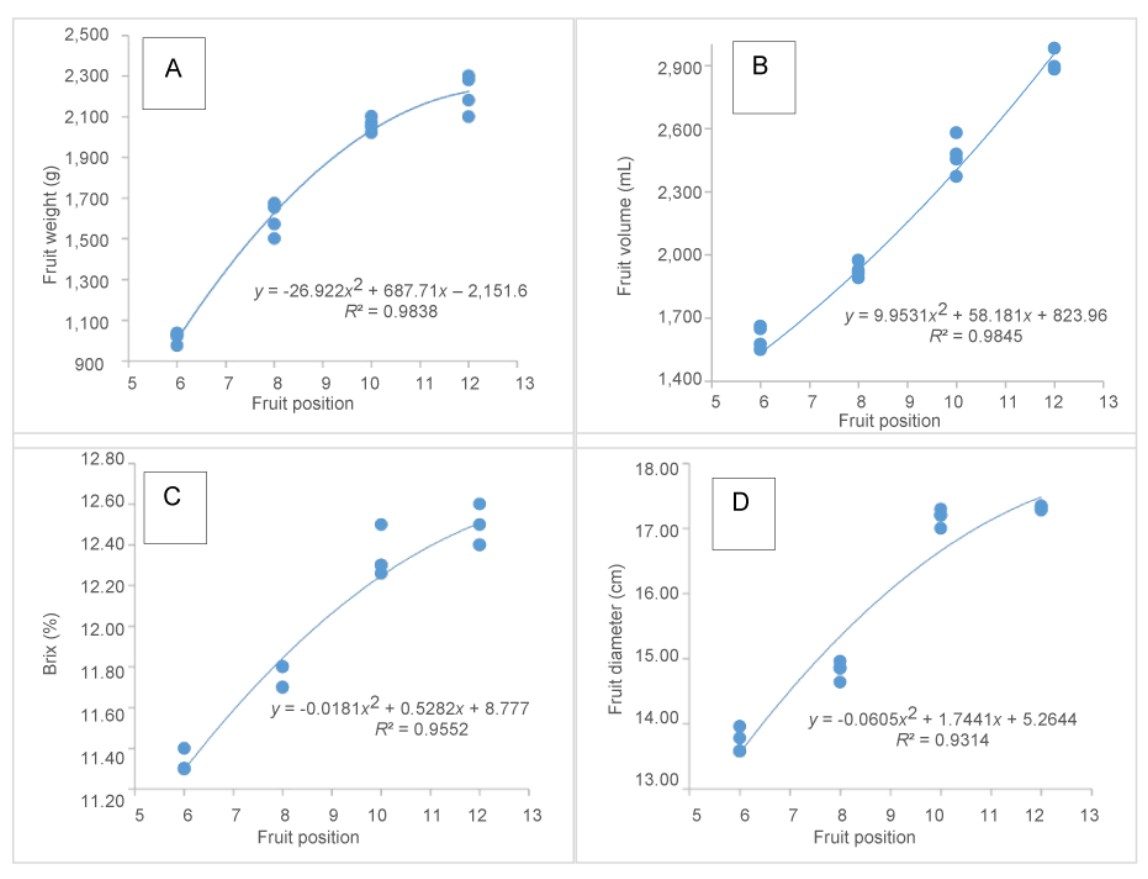
Figure 3 Relationship between fruit position and yield parameters. Fruit position in relation to fruit weight ( A ), fruit volume ( B ), fruit sweetness ( C ), and fruit diameter ( D ) of melon